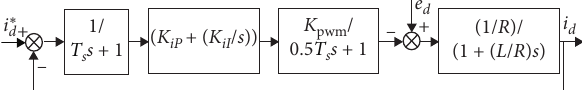
Figure 7: The control diagram of inner current loop.